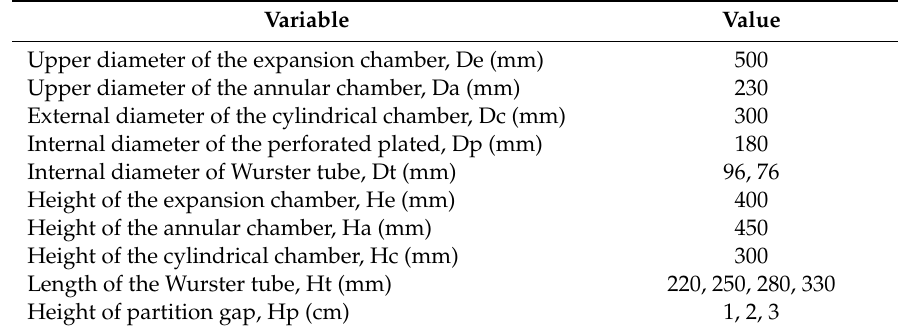
Table 1. Dimensions of the components of the Wurster fluidized bed. Variable Value Upper diameter of the expansion chamber, De (mm)